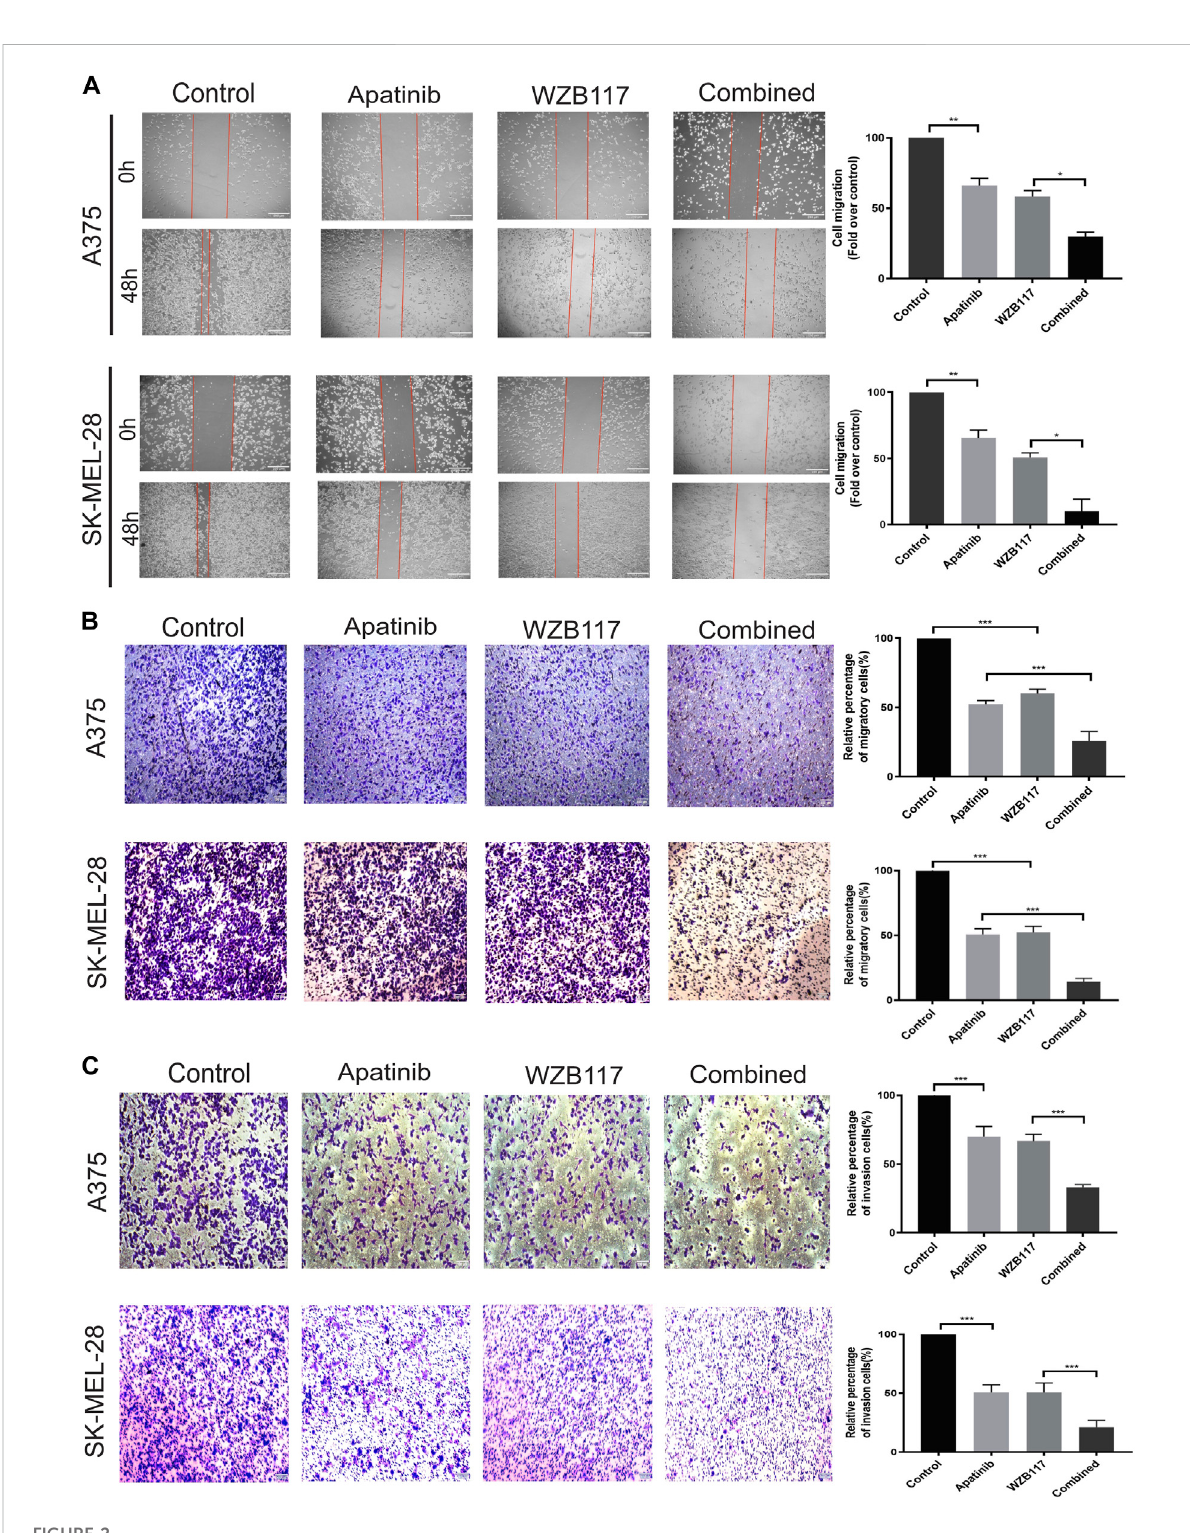
FIGURE 2 Apatinib combined with WZB117 showed synergistic migration and invasion inhibitory effects in A375 and SK-MEL-28 cells. (A) Apatinib and WZB117 inhibit lateral migration ability. The microscopic appearance of scratches in both cells at 0 and 48 h are shown in the left panels, and relative quanti fi cationdataareshowninthe right panels.Scalebar=200 µm.Quantitativedataarepresentedasthemean±SDofthreeindependentexperiments. (B) ApatinibandWZB117inhibitverticalmigrationability.Themicroscopicimagesareshowninthe left panels,andrelativequanti fi cationdataareshown inthe right panels.Scalebar = 100 µm. Quantitative dataare presentedasthemean± SD of fi ve independentexperiments. (C) ApatinibandWZB117inhibit invasion ability. The microscopic images are shown in the left panels, and relative quanti fi cation data are shown in the right panels. Scale bar = 100 µm. Quantitative data are presented as the mean ± SD of fi ve independent experiments. “ * ” means p < 0.05, “ ** ” means p < 0.01, and “ *** ” means p <